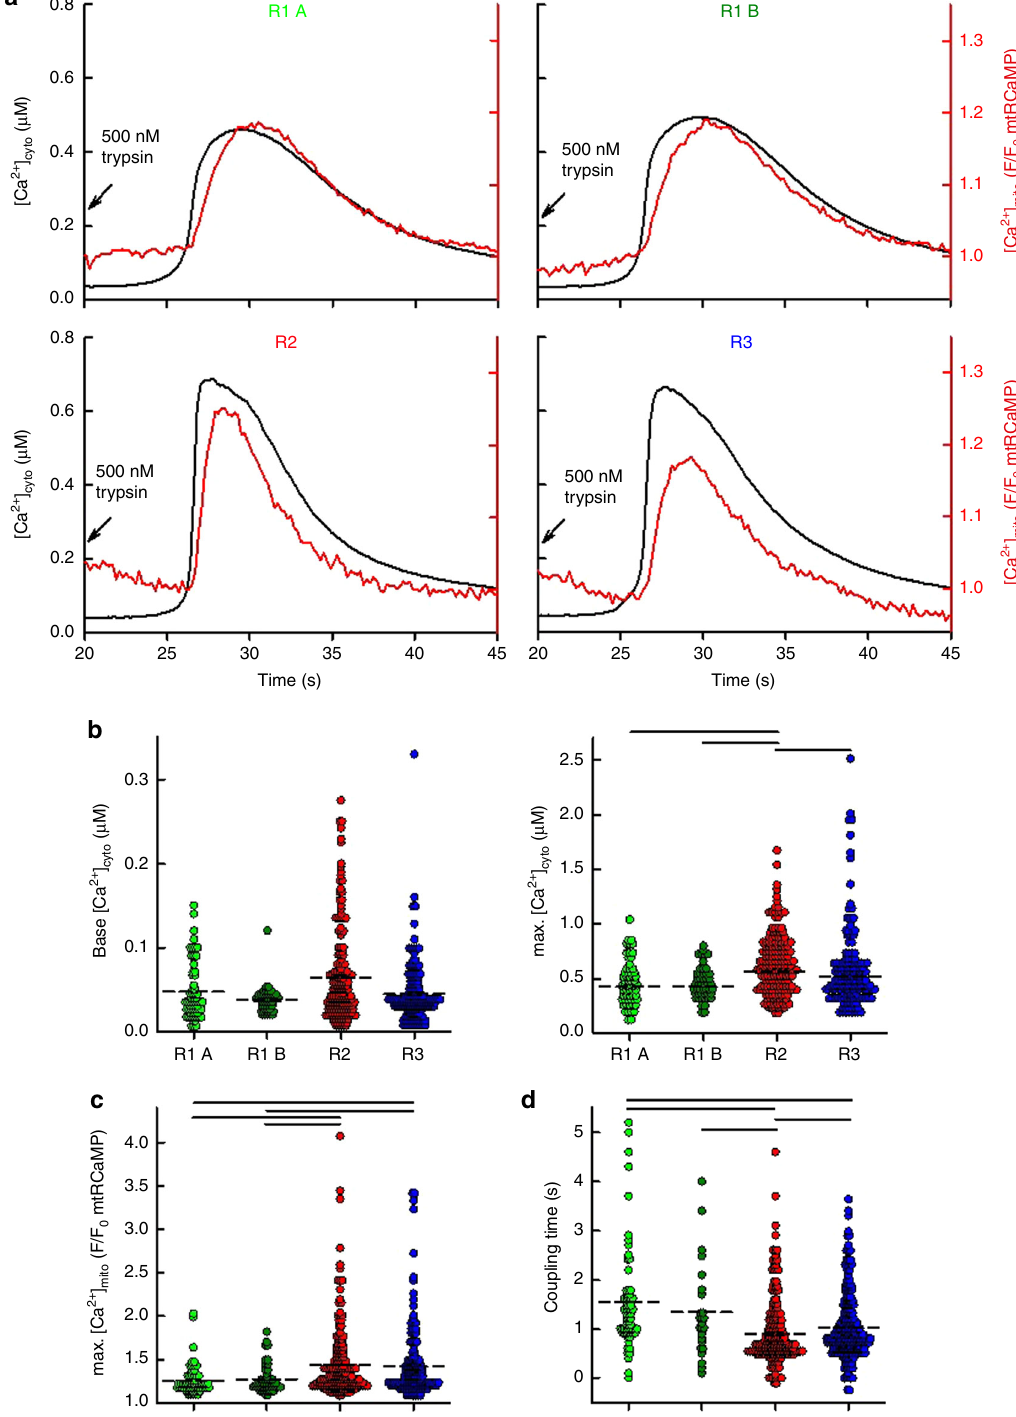
Fig. 4 IP3R2 is the most ef fi cient coupler of agonist-induced Ca 2 + signal. a To monitor Ca 2 + transfer from ER to mitochondria [Ca 2 + ] mito and [Ca 2 + ] cyto were imaged simultaneously using a wide- fi eld EMCCD imaging setup in intact cells transfected with mitochondrial matrix-targeted mtRCaMP and loaded with fura2. IP 3 dependent Ca 2 + -release was stimulated with 500nM trypsin. Average traces of [Ca 2 + ] cyto (black) and [Ca 2 + ] mito (red) are shown. Individual traces ( N = 24, 30, 19, and 21 cells, respectively, in fi ve independent experiments) were synchronized to the half-activation time of the [Ca 2 + ] cyto signal. b Baseline cytoplasmic Ca 2 + levels (left panel) and peak values (right panel) followed by trypsin stimulation (mean, dashed lines). c Maximal [Ca 2 + ] mito responses (mean, dashed lines). d Coupling times (mean, dashed lines): difference of the half-activation times of the [Ca 2 + ] cyto and [Ca 2 + ] mito signals for individual cells. b – d Black lines indicate p < 0.05 with one-way ANOVA with post-hoc Dunn ’ s Method, N = 61, 49, 179, and 152 cells, respectively, from four independent experiments. Source data are provided for panels b , c , d as a Source Data fi